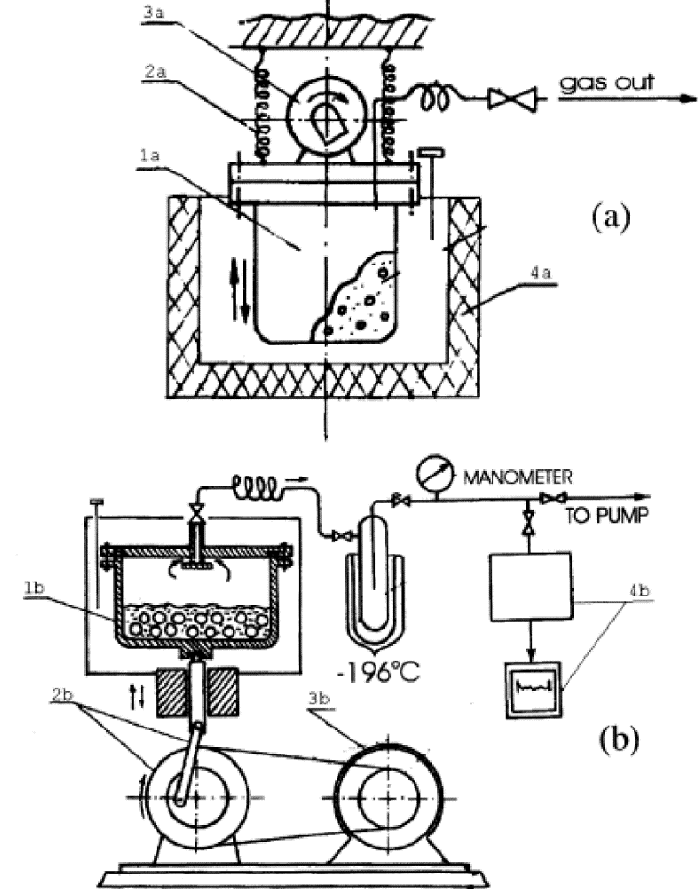
Figure 11. The schematic design of a vibratory hermetic ball mill for mechanochemical reactions, described by Schlesinger: ( a ) a mill with the inertial eccentric vibrator: 1a—mill body with the balls and reactants; 2a—elastic suspension support (springs); 3a—vibrator with the electric motor; 4a—Dewar vessel; ( b ) mill with the crank drive: 1b—mill body with the balls and reactants; 2b—crank drive of the vibrator; 3b—electric motor; 4b—automatic gas burette with recorder [177].